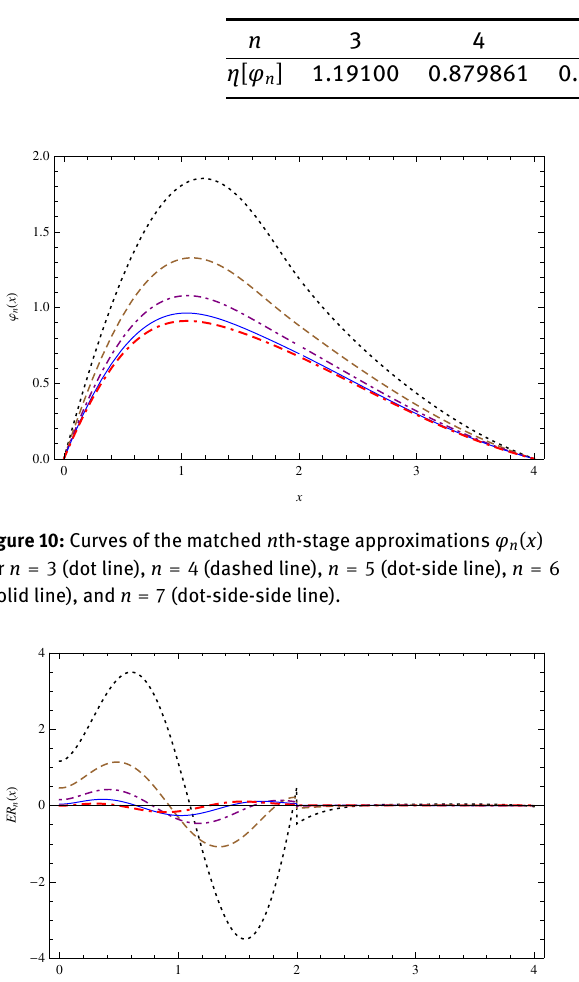
Table 7: The values of the η [ φ n ] for n = 3, 4, 5, 6, 7 .